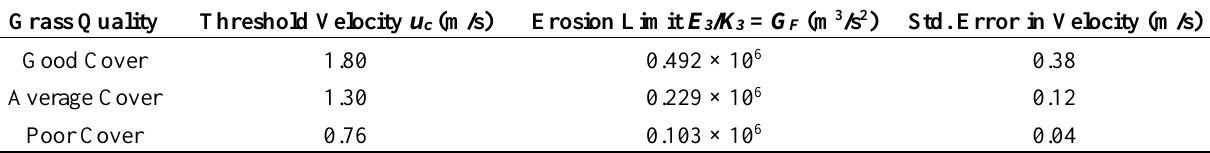
Table 1. Results for the best-fit of Equation (3) to the Hewlett et al. [12] grass curves. Grass